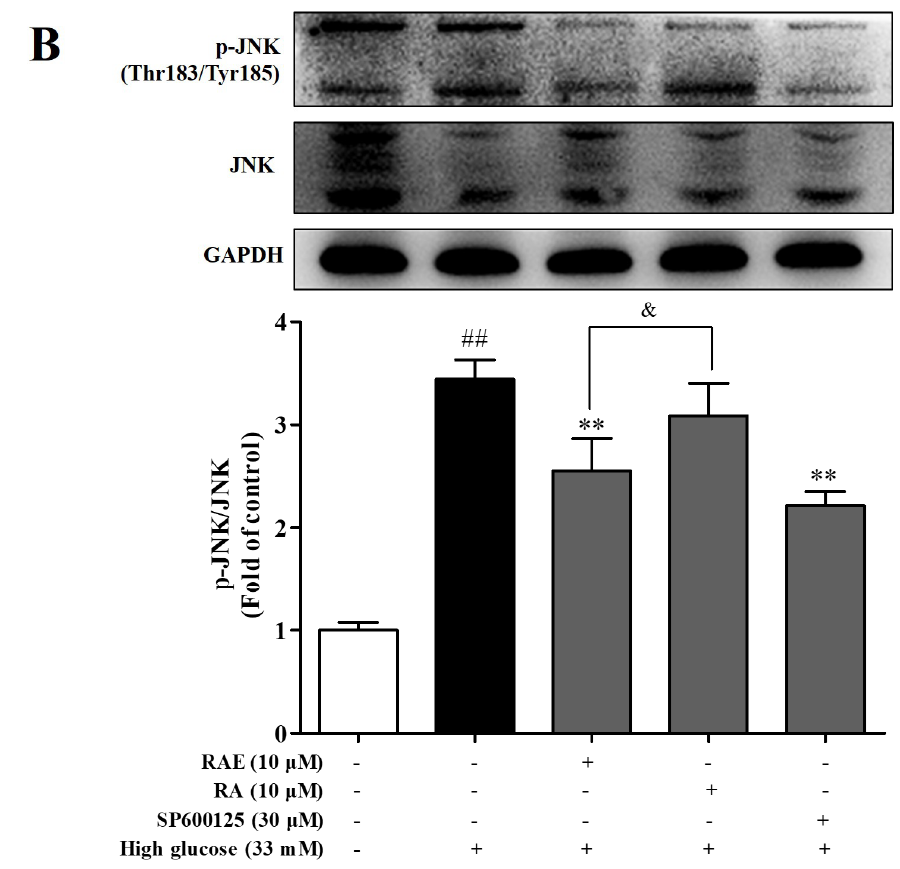
Figure 6. Effect of RAE on nuclear factor-κB (NF-κB) and c-Jun N-terminal kinase (JNK) activation in endothelial cells treated with high glucose. EA.hy926 cells were treated with or without RAE (10 µM) or RA (10 µM) in the medium containing 33 mM of glucose for 48 h. Cells were exposed to PDTC (10 µM) ( A ) and SP600125 (10 µM) ( B ) for 30 minutes before incubation with high glucose and RAE for 48 h. Then, the cell lysates were collected. The phosphorylation of NF-κB and JNK were detected by Western blot using a phosphor-specific related antibody. The results were expressed as mean ± SD (n = 5), and one representative image of five individual experiments was shown. ## P < 0.01, vs. control; * P < 0.05, ** P < 0.01, vs. high glucose; & P < 0.05, vs. RAE (10 µM) group.